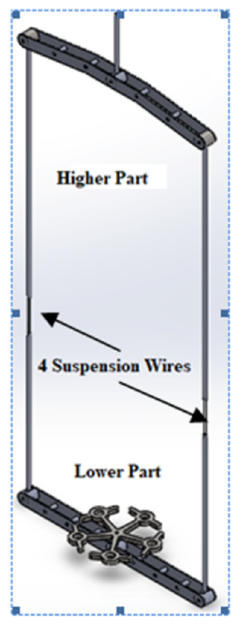
Fig. 2. The developed weighing pan.